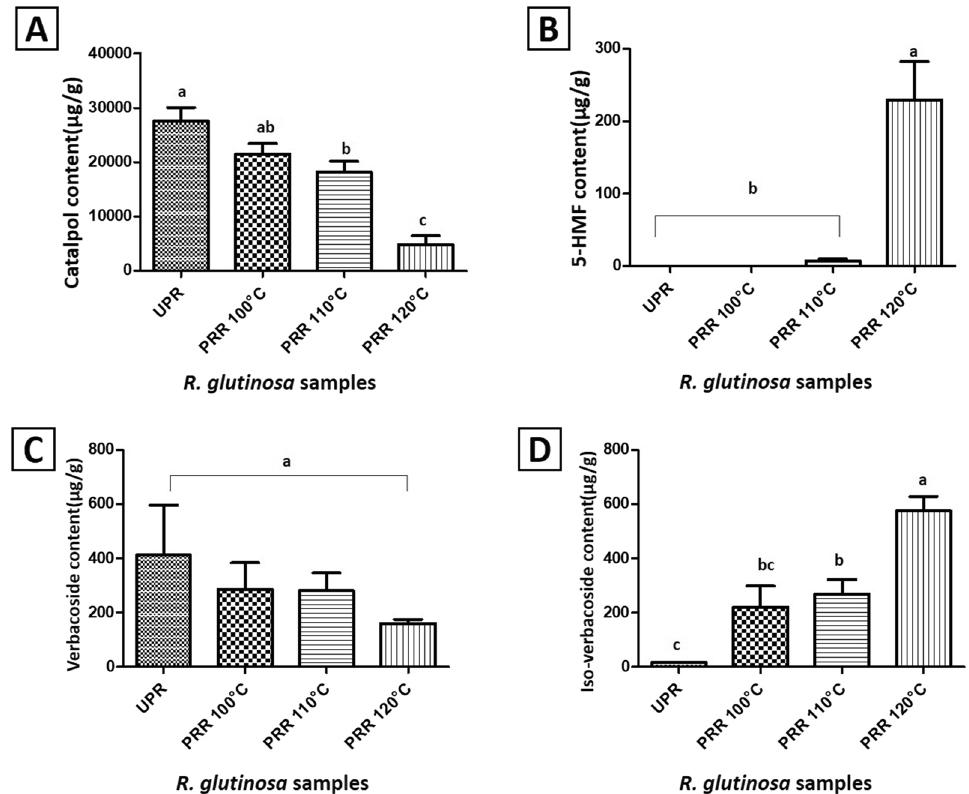
Fig. 3 Effect of different steaming temperature (100 ℃ , 110 ℃ , and 120 ℃ ) on marker compounds content of R. glutinosa samples. a Catalpol content of R. glutinosa samples. b 5-HMF content of R. glutinosa samples. c Verbacoside content of R. glutinosa samples. d Iso-verbacoside content of R. glutinosa samples. * UPR Unprocessed R. glutinosa , PRR Processed R. glutinosa . Values are presented as means standard deviation. Same letters ± are not significantly different by Tukey’s test and p =